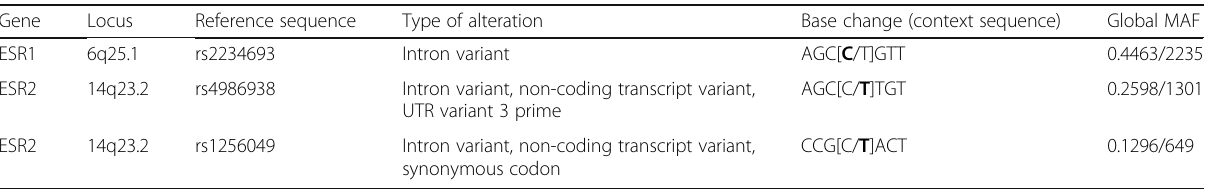
Table 1 Single-nucleotide polymorphisms studied Gene Locus